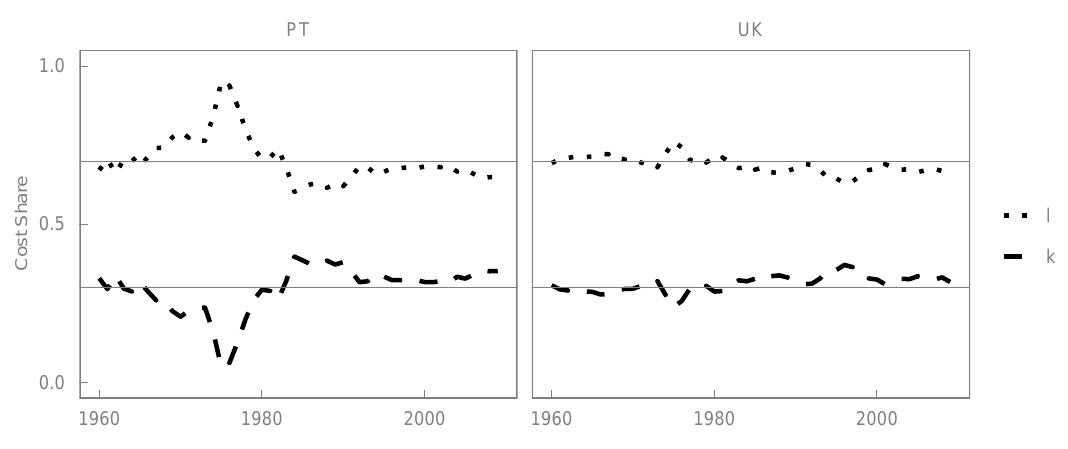
Figure 2. Historical cost shares for capital ( k ) and labor ( l ) for Portugal and the United Kingdom. Horizontal grid lines are placed at 0.3 and 0.7, the values of α k and α l , respectively, used in models that adhere to the cost share principle